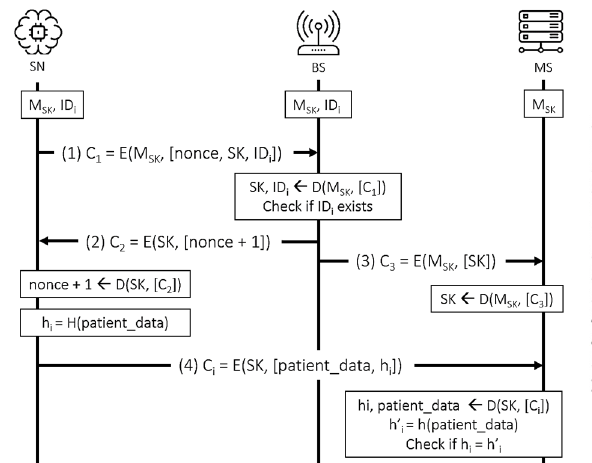
Figure 12. Iqbal et al.’s protocol.